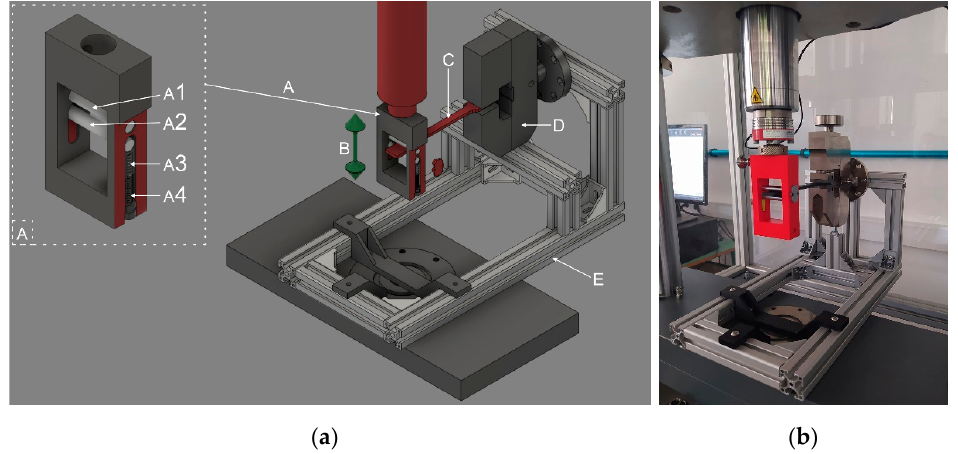
Figure 3. ( a ) The models used in the setup of the flexural fatigue test measurement: ( A ) special gripper; ( A 1) fixed roller; ( A 2) moving roller; ( A 3) spring; ( A 4) adjusting screw; ( B ) moving direction; ( C ) specimen; ( D ) screw grip; and ( E ) support frame. ( b ) The assembled device for the flexural fatigue test measurement [30].